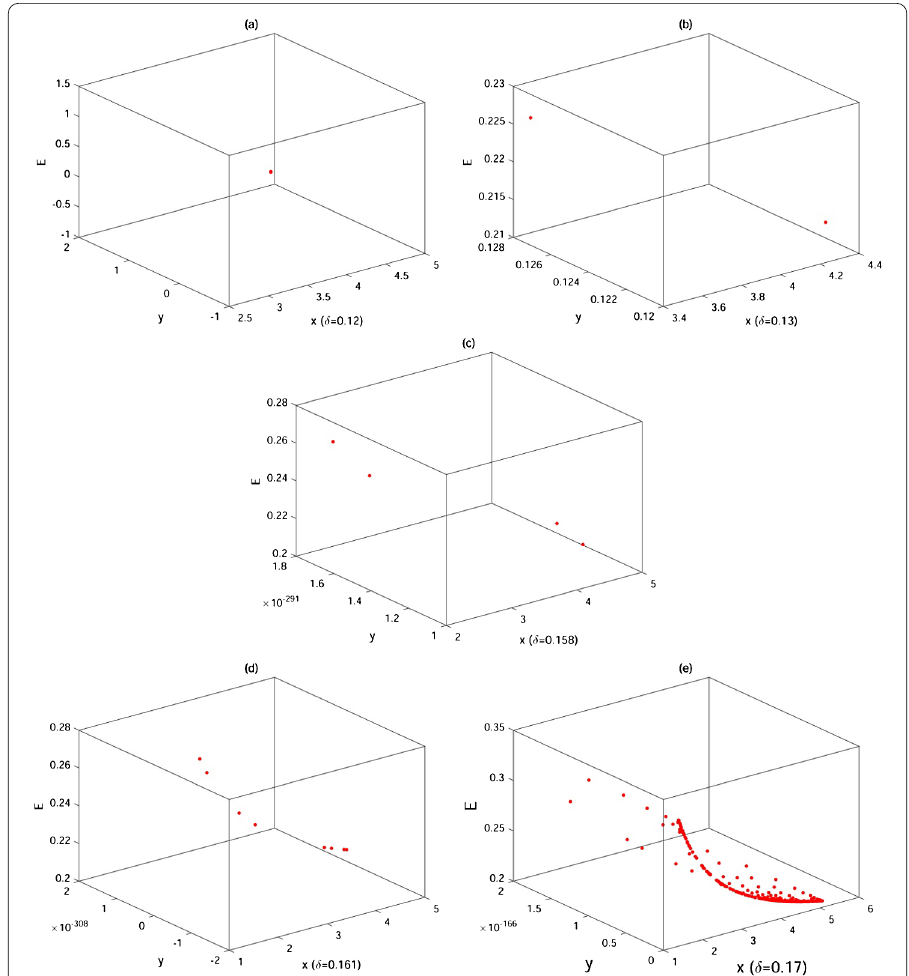
Figure 5 Phase portraits for different values of δ corresponding to Fig. 4. (a) δ = 0.12, (b) δ = 0.13, (c) δ = 0.158, (d) δ = 0.161, (e) δ =